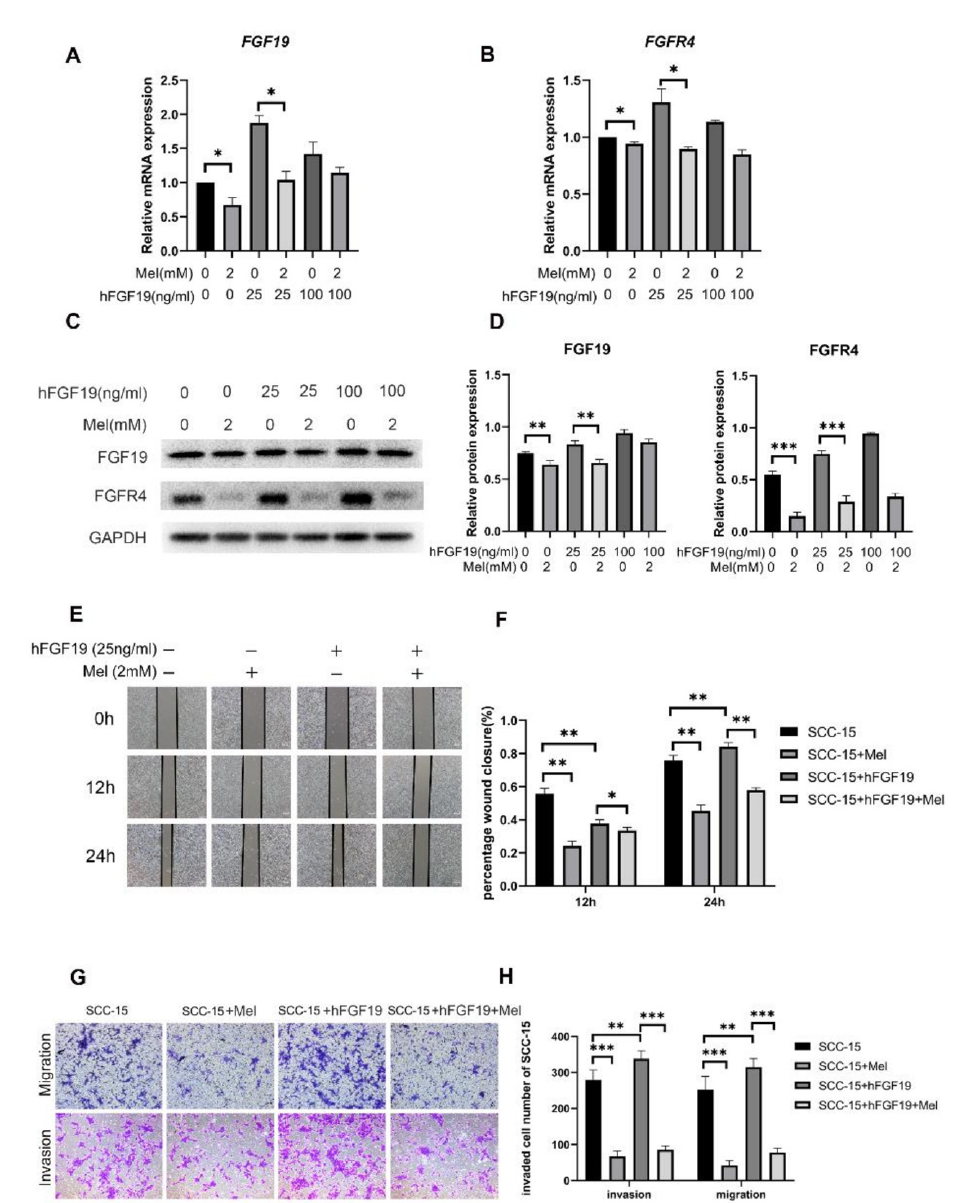
Figure 3. The effect of melatonin on cell migration and invasion in SCC-15 cells with or without FGF19 overexpression. The mRNA ( A , B ) and protein expression levels of FGF19/FGFR4 ( C ) after hFGF19 overexpression. The invasion and migration ability of cell was determined by trasnwell migration assays at 24 h ( G ), transwell invasion assays at 36 h ( G ) and wound healing at 12 h, 24 h, 36 h ( E ) (Scale bars: ( E , G ), 100 nm). Quantitative data from three independent experiments are shown in the right panels, respectively ( D , F , H ). * p < 0.05; ** p < 0.01, *** p <